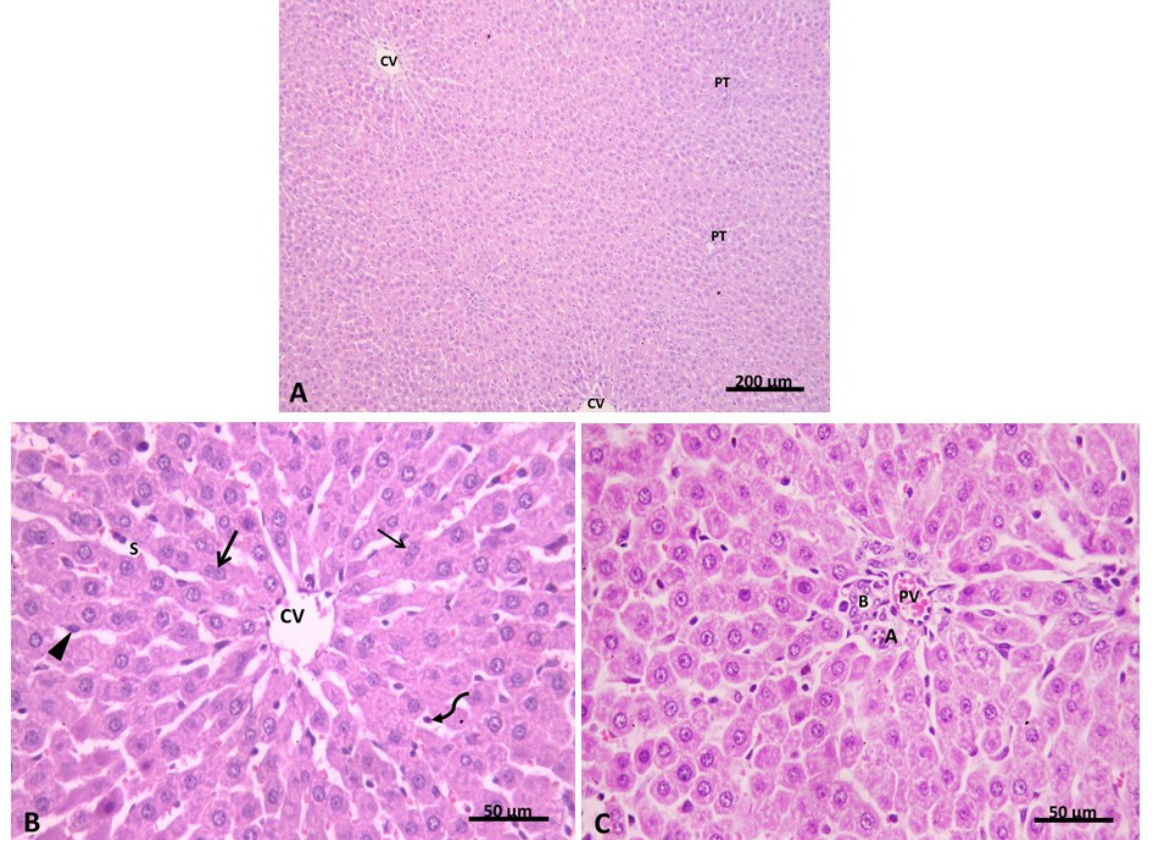
Figure 5. ( A ) showing the regular appearance of classic hepatic lobules with central veins (CV) and peripheral portal tracts (PT). ( B ) Group I. H&E ×100 shows hepatocyte cords radiating from the central vein (CV). Polygonal hepatocytes are seen with acidophilic cytoplasm containing basophilic granules and central rounded vesicular nuclei. Some cells are binucleated ( ↑ ). Blood sinusoids (S) are lined with flat endothelial cells ( ▲ ) and Kupffer cells (curved arrow). ( C ) Group I. H&E × 400 showing portal tract containing branches from the portal vein (PV), hepatic artery (A), and bile duct (B) Group I. H&E ×400.